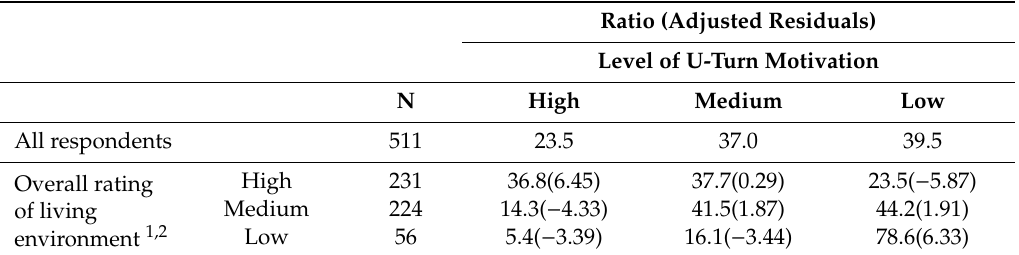
Table 3. The di ff erence in U-turn motivation according to the evaluation of living environments in their hometown.